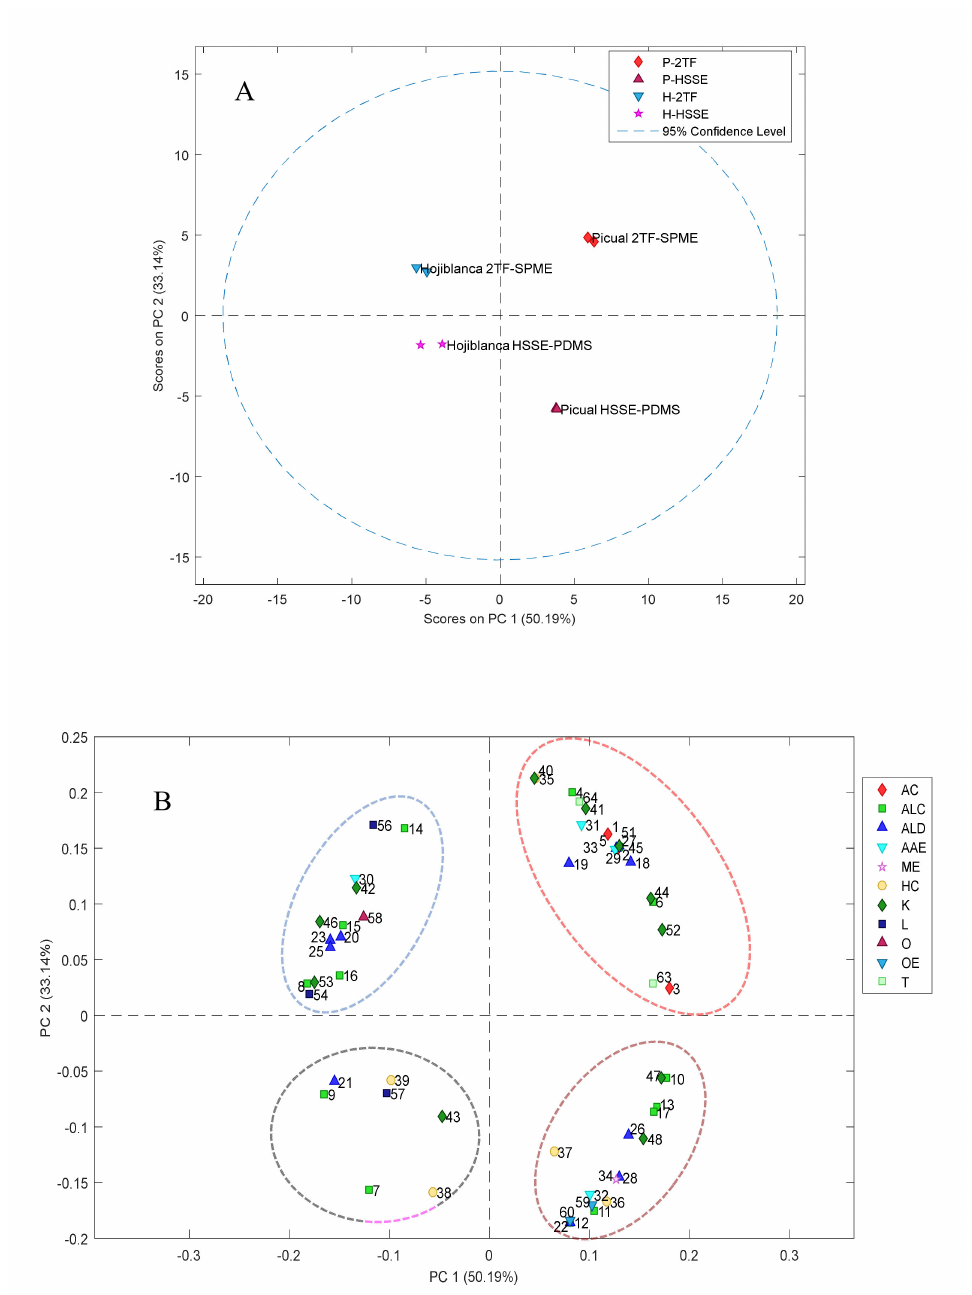
Figure 3. Application of PCA to the solved chromatographic profiles obtained by the HSSE-PDMS and 2TF-SPME extraction methods. ( A ) Score plot; ( B ) loading plot (the correspondence between numbers and volatile compounds is shown in Table